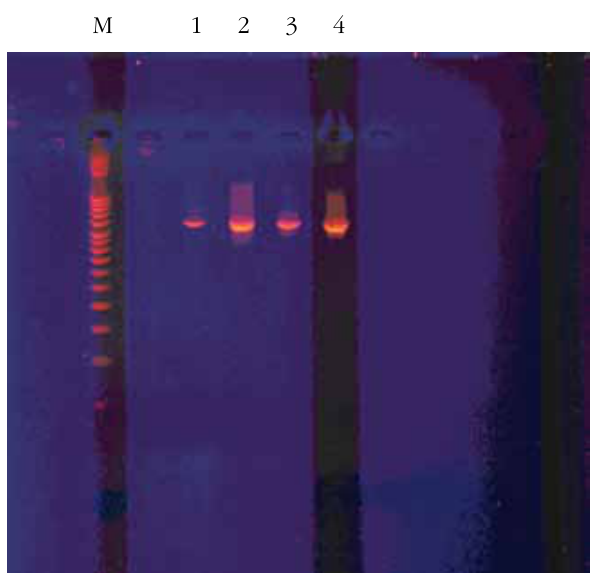
Fig. 2 – Species specific PCR of Borrelia burgdorferi sensu lato iso- lates; Lines: M, DNA size marker, 50 bp DNA ladder; 1 (tick pool 1), isolate amplified with primers specific for Borrelia burgdorferi sensu stricto; 2-4, isolates (Tick pool 2-4) amplified with primers specific for Borrelia afzelii